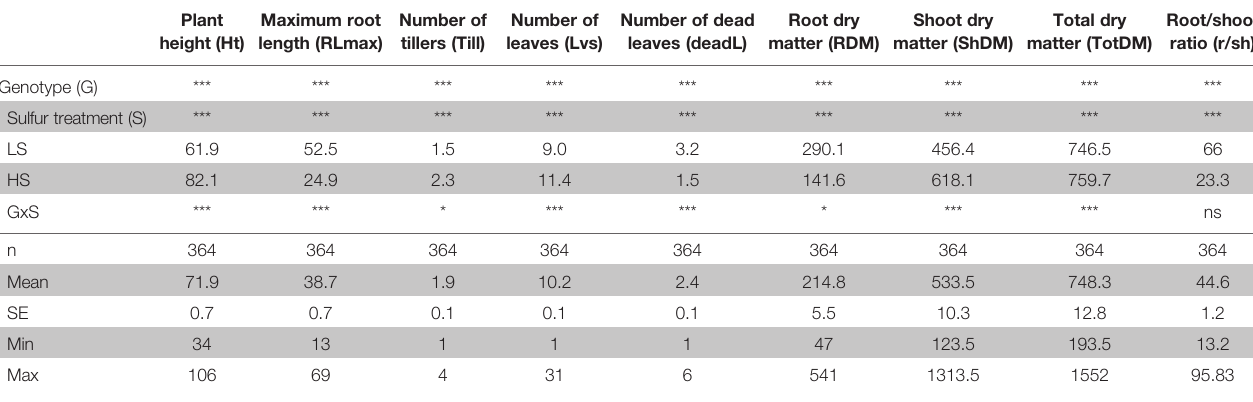
TABLE 1 | Summary of two-way analysis of variance (ANOVA) from phenotypic traits measured in plants grown under low-S and high-S treatment.